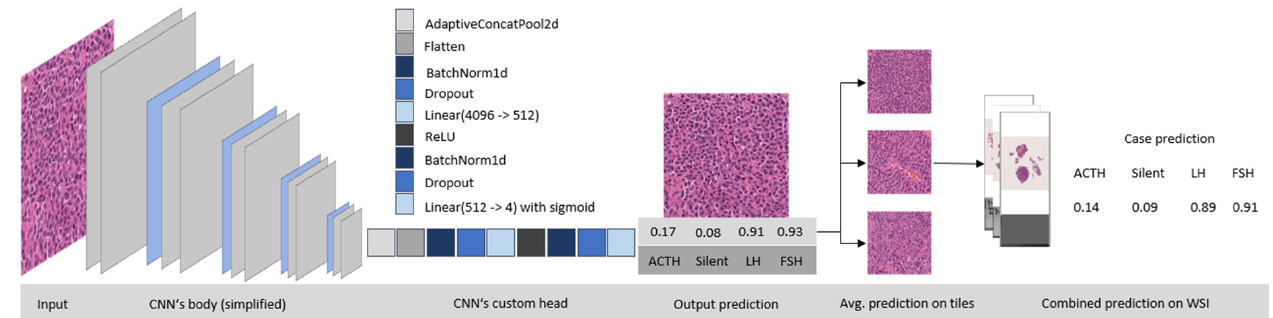
Figure 6. Prediction Pipeline. A tile is forwarded through the model, and the model outputs four independent probabilities for each class. If the probability is over a certain threshold (0.5), the tile obtains the label. All tiles of one case are evaluated, and if more than 50% of the tiles are labeled with one class, the case is also labeled with that class (majority voting).